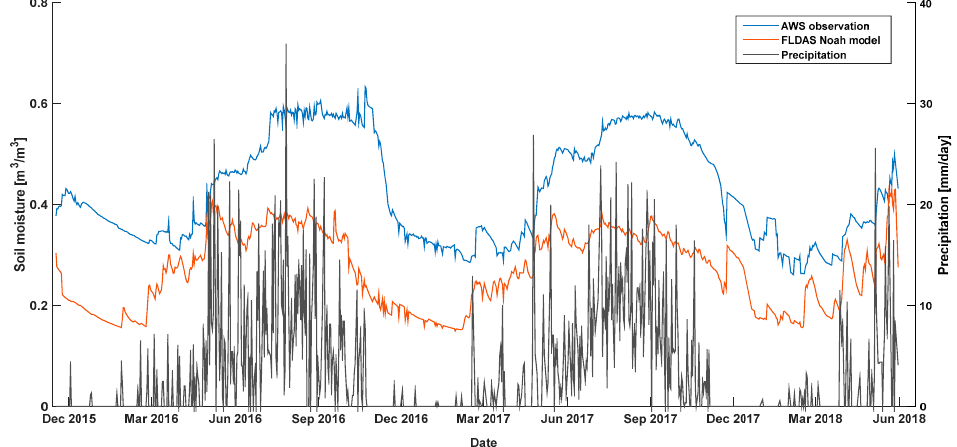
Figure 2. Time series of daily mean automatic weather stations (AWS) measured volumetric soil moisture (blue line) and daily values of Land Data Assimilation System (FLDAS) Noah simulated (red line) soil moisture and daily accumulated precipitation (black line) over the six observation stations for the period of November 2015 to May 2018.